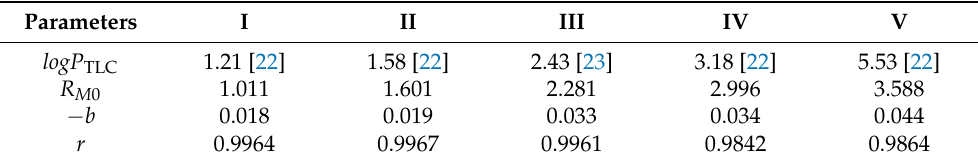
Table 3. R M0 and logP lit . values and b (slope) and r (correlation coe ffi cient) of the equation R M = R M0 + Table 3. R M 0 and logP lit . values and b (slope) and r (correlation coefficient) of the equation R M = R M 0 b C for standards I – V . + b C for standards I – V .